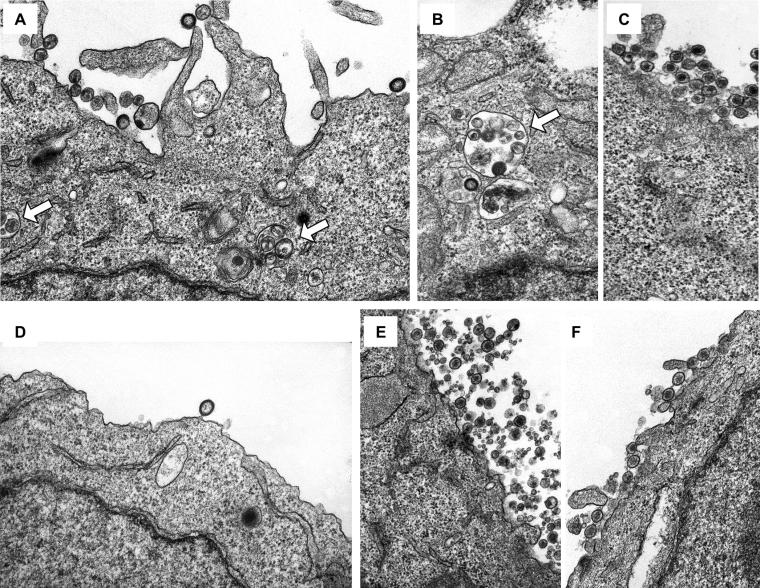
Electron Microscopy Examination of HIV-1 Assembly and Effects of Vpu and Endocytosis InhibitionHela cells expressing Gag-Pol in the presence or absence of Vpu or Rab5a(S34N) were examined.(A–C) Examples of cells expressing Gag-Pol only, revealing mature particles at both the PM (A and C) and within internal, apparently membrane-bound compartments (arrows in A and B). Immature budding structure are also observed at the PM but only rarely within endosomes.(D) Cells co-expressing Gag-Pol and Vpu with reduced numbers of cell-associated particles, and absence of particles from endosomes.(E and F) Cells co-expressing Gag-Pol and Rab5a(S34N), with exclusively surface-accumulated virions.